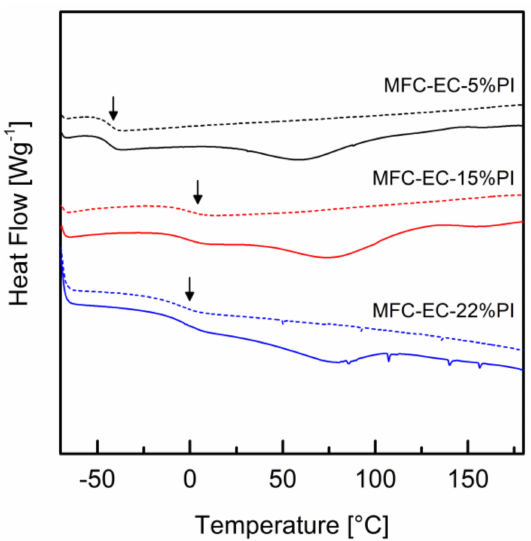
Figure 12. DSC thermograms of the cured composites with di ff erent photoinitiator concentrations. Full lines are for the first heating run and dashed lines for the second heating run in the DSC. The arrows indicate the glass transition